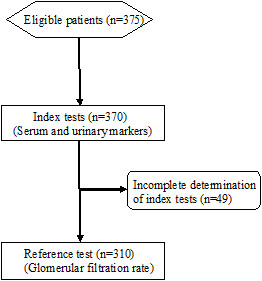
Flow diagram of the chronic kidney disease patients that entered the study.